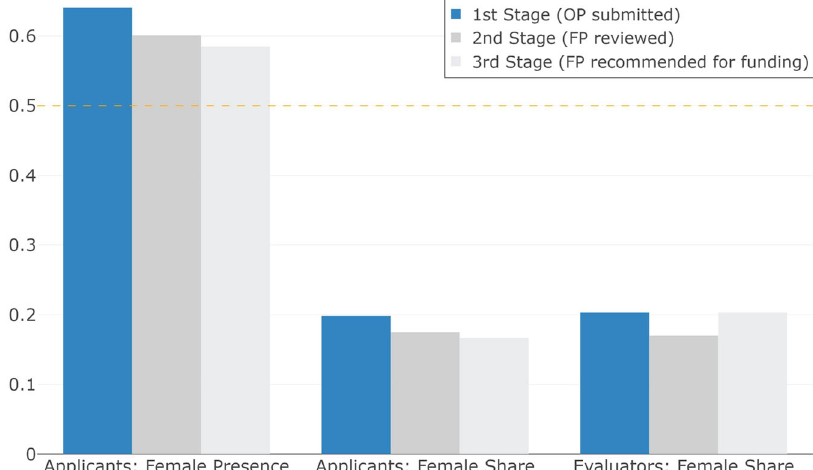
Fig. 2 Gender statistics for applicants andevaluators. ‘ Female Presence ’ represents the proportion of consortia with at least one female PI. ‘ Female Share ’ is the proportion of female PIs in consortia or evaluator